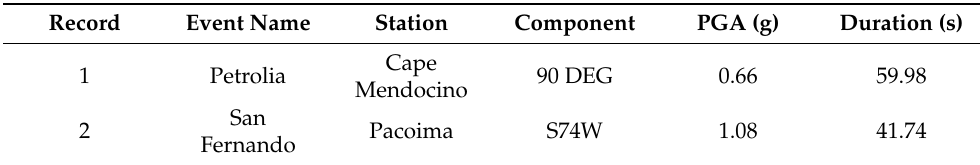
Table 6. Details of the new ground-motion records used.